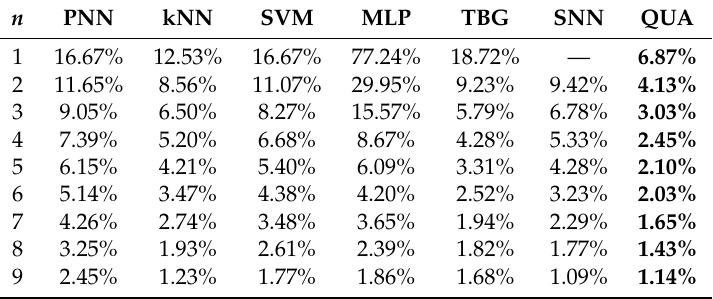
Figure 3. Dependence of the average error rate of different classifiers in the problem of gesture recognition on the number of training samples per class n . Table 2. Person recognition error rate. The first column, labelled n , denotes the number of training samples per class. The best result in a given row is shown in bold and indicates the least erroneous